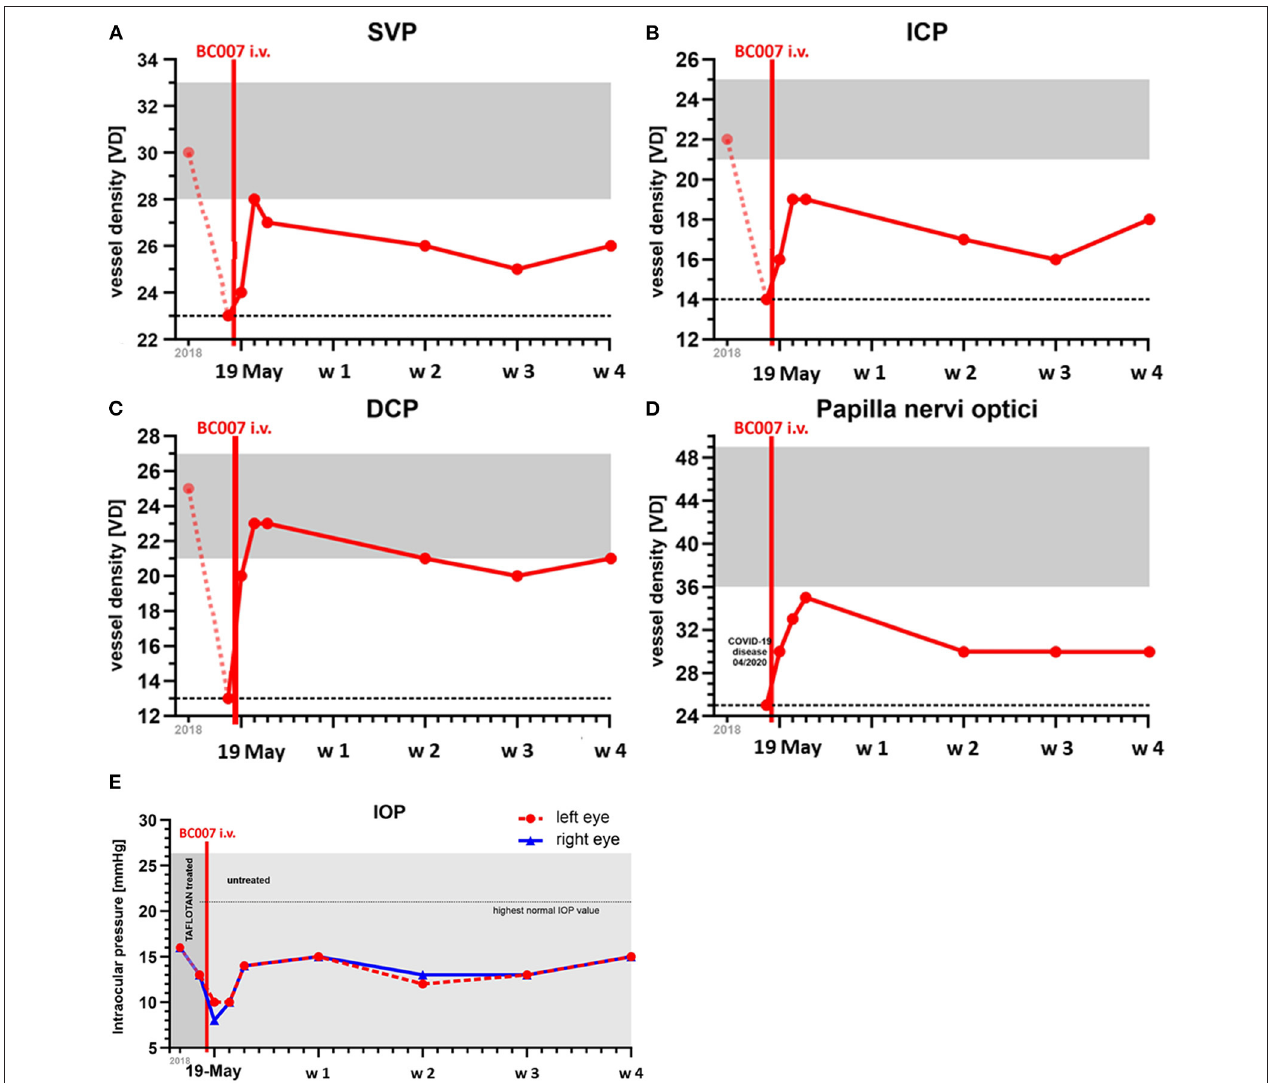
FIGURE 2 | Measurement of ocular parameters (capillary microcirculation, A–D ; intraocular pressure, E ): Capillary microcirculation of the macula and peripapillary region, scanned by optical coherence tomography-angiography (OCT-A): vessel density (VD) was monitored in the three layers of the macula (superficial vascular plexus, SVP, A ; intermediate capillary plexus, ICP, B ; deep capillary plexus, DCP, C ) and peripapillary region (D) . Vessel density of the macula was reduced after COVID-19 infection compared to the preexisting data of 2018. After treatment with BC 007, the VD increased in all the three layers of the macula and peripapillary region, being stable over at least during the observation period of 4 weeks (gray: range of VD in normal eyes, dotted line: reference level of VD after COVID-19 infection). Data of the left eye are shown as the quality of the OCT-A scans of the right eye were not exploitable due to a hindered fixation of the patient by the presence of cataract. (E) Intraocular pressure (IOP, mmHg; measured by Goldmann applanation tonometry) was monitored before and after treatment with BC 007; reference data of 2018 (EGR, ISSN 2191-5008, CS-2011; NTC00494923) were presented: IOP was reduced after treatment with BC 007, as IOP level was stable,